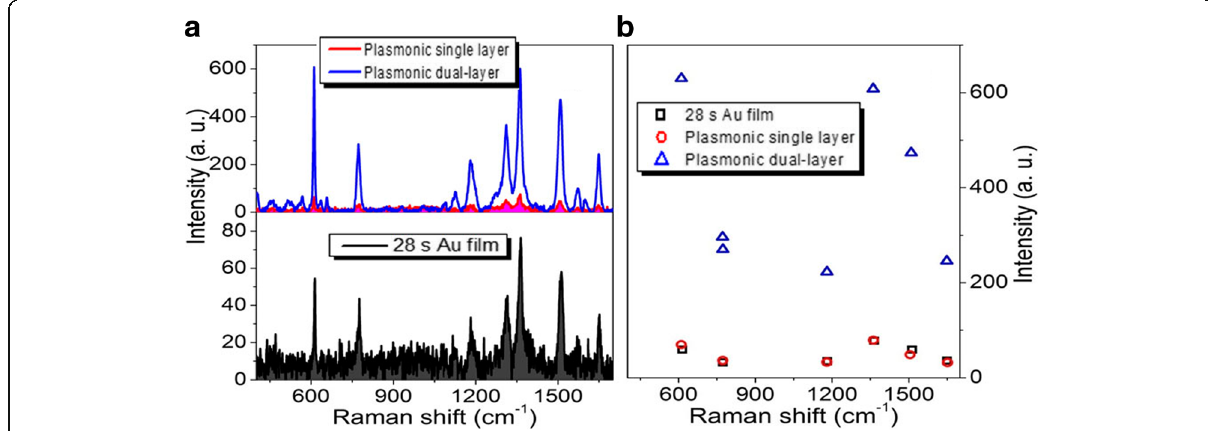
Fig. 4 a Raman spectra of the single-layer and dual-layer porous Au film structures and ultrathin Au film. b Intensity changes of several typical Raman peaks observed in the three Raman curves in a . The sputtering time for each layer of porous Au films and film is 28